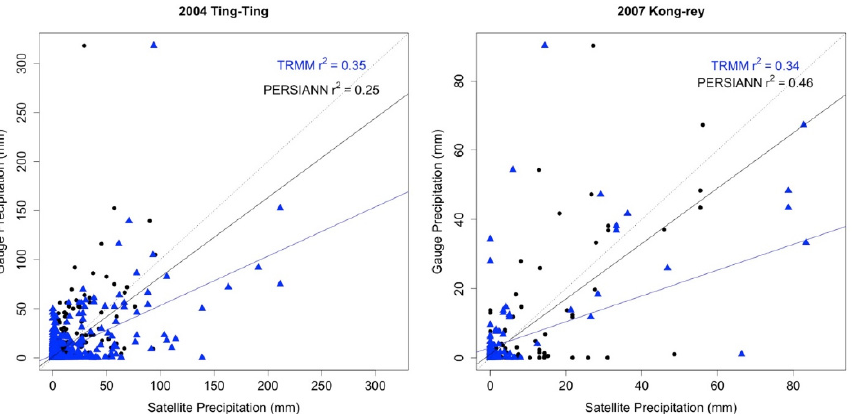
Figure 7. Scatterplots of satellite precipitation and in situ gauge precipitation during the 2004 Typhoon Ting (left) and 2007 Typhoon Kong-rey (right). Linear regression lines are shown along with r-squared values for TRMM TMPA and PERSIANN.